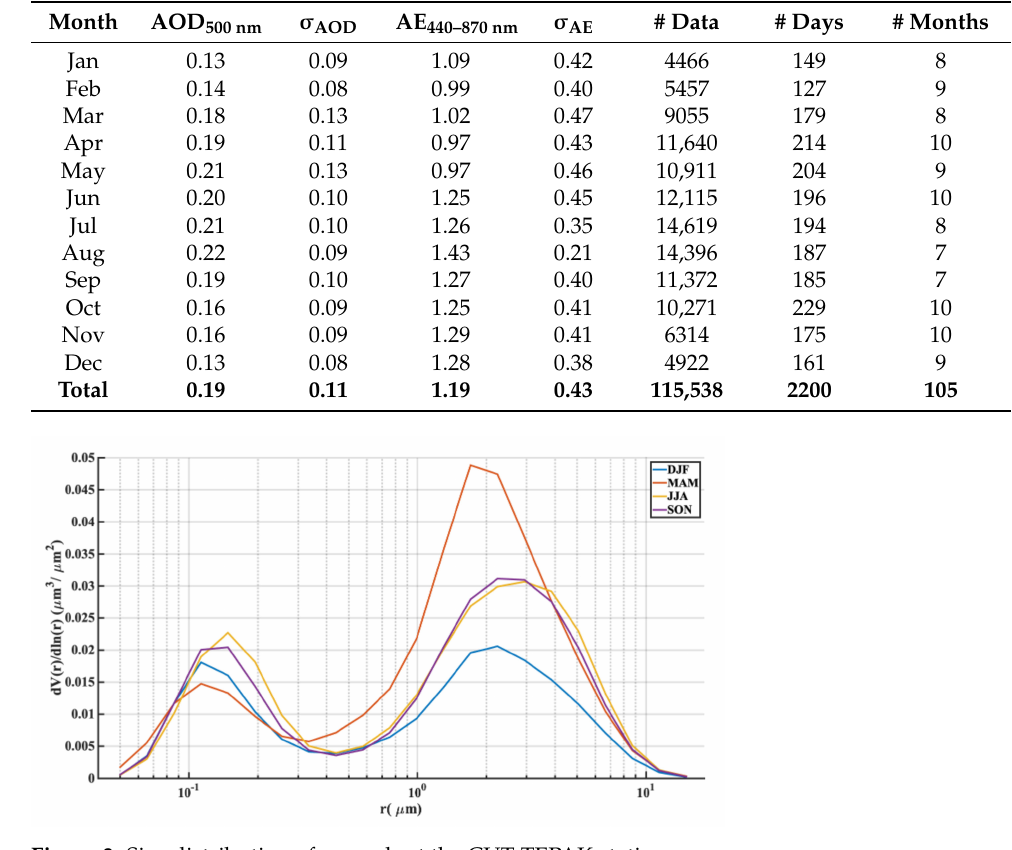
Figure 3. Size distribution of aerosols at the CUT-TEPAK